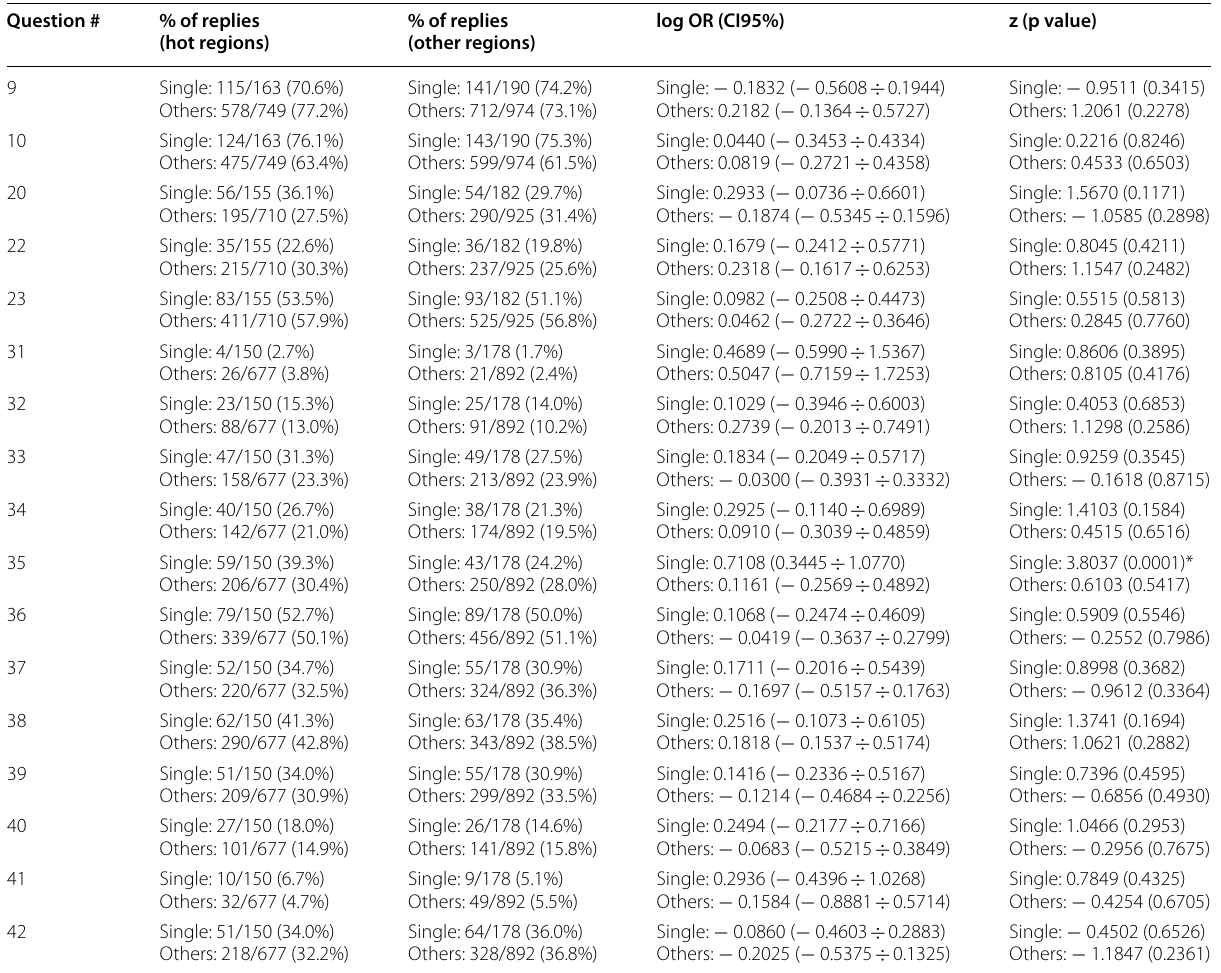
Table 3 Distribution of answers in hot and other regions stratified by respondents’ living condition (i.e. single or